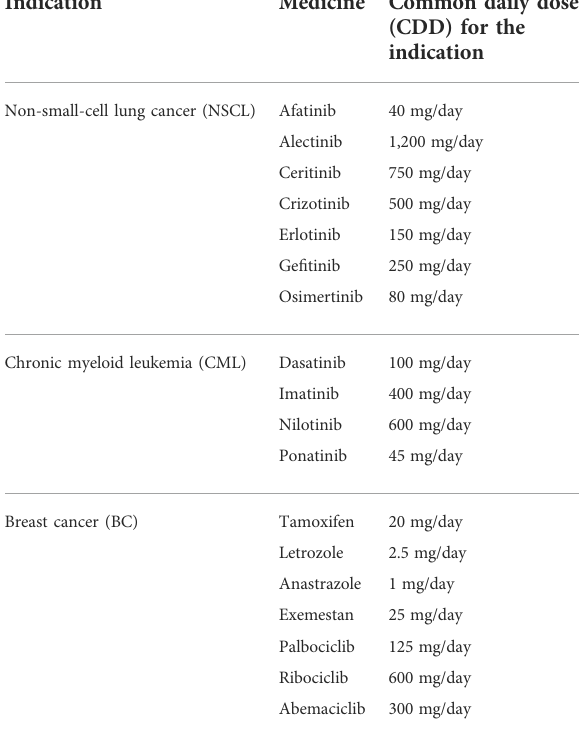
TABLE 1 CDD for medications administered orally for selected indications. Indication Medicine Common daily dose